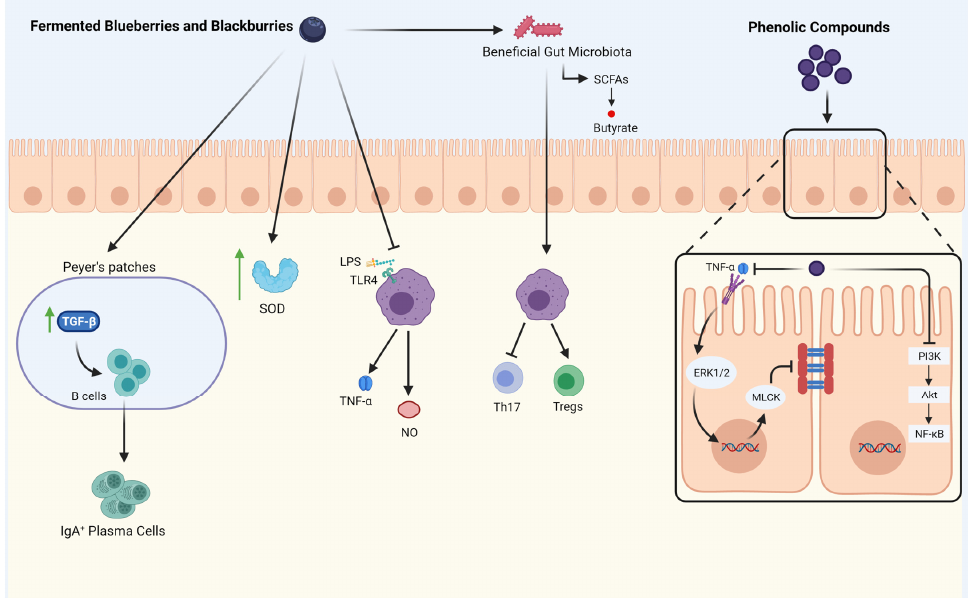
Figure 1. The Anti-inflammatory and Immunomodulatory activity of fermented berries. ↑ : increase; TGF- β : transforming growth factor-beta; IgA: immunoglobulin A; SOD: su-peroxide dismutase; LPS: Lipopolysaccharide; TLR4: Toll-like receptor-4; TNF- α : tumor necrosis factor; NO: nitric oxide; SCFAs: short-chain fatty acids; Th17: T helper 17; Tregs: regulatory T cells; PI3K: phosphatidylinositol 3 kinase; AKT: protein kinase B; NF- κ B: nu-clear factor-kappa B; MLCK: myosin light-chain kinase; ERK: signal-regulated kinase.